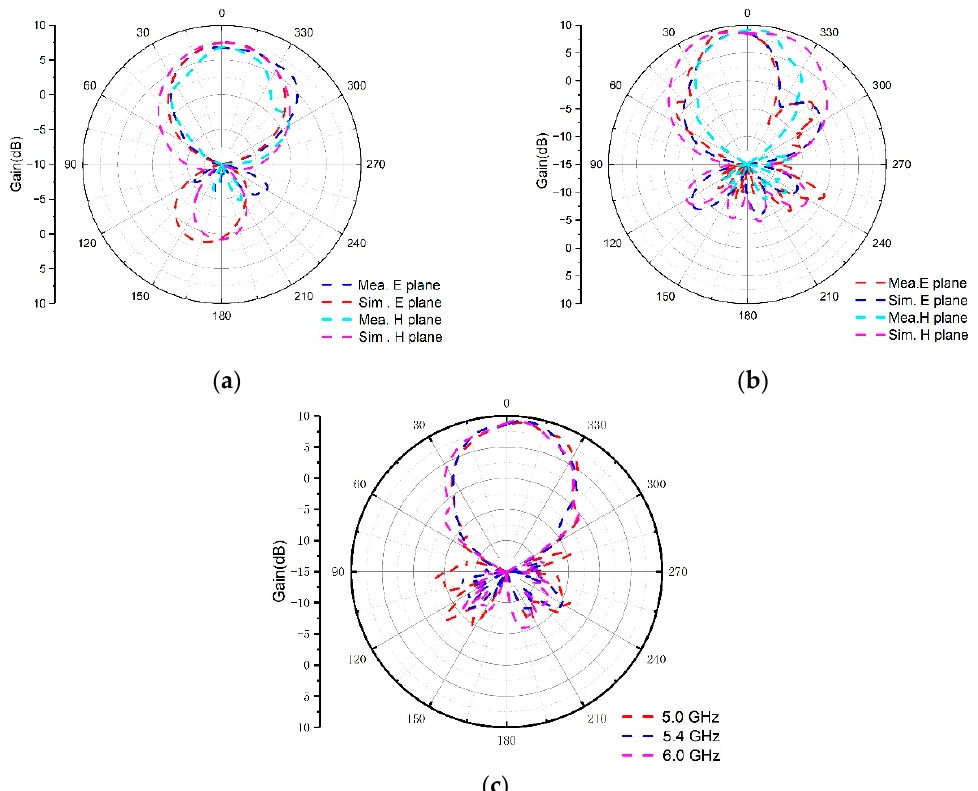
Figure 13. The radiation patterns of the proposed antenna at ( a ) 2.45 GHz, ( b ) 5.8 GHz, and ( c ) 5.0, 5.4, and 6.0 GHz.